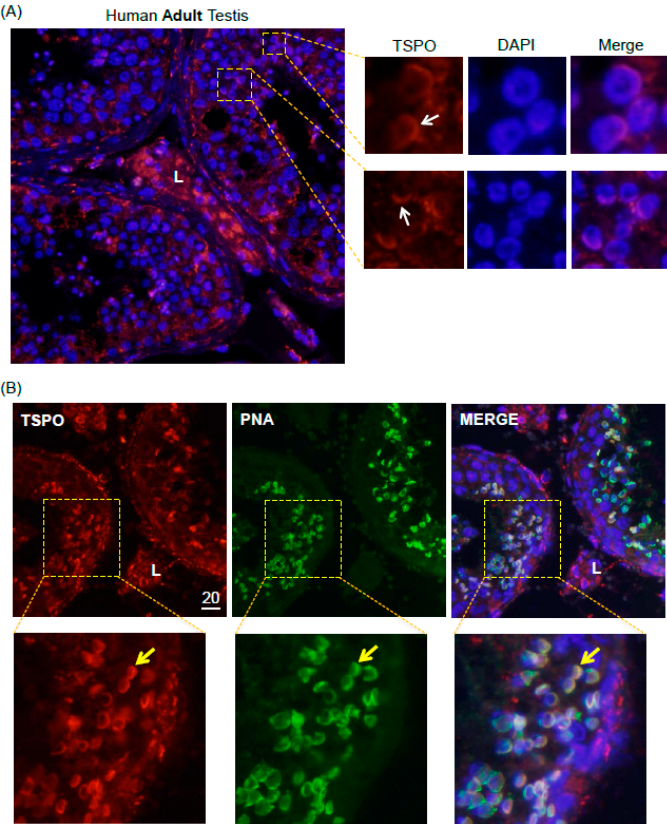
Figure 4. TSPO protein expression in normal human adult testis. Immunofluorescence (IF) analysis was performed on paraffin sections. ( A ) Patient 1. Red : TSPO protein expression; Blue : DAPI nuclear staining. Leydig cells are indicated by “L”. Areas showing expression in round spermatids (acrosomal formation) are shown in enlarged panels. Representative images are shown; ( B ) Patient 2. Red : TSPO protein expression; Green : PNA labeling; Blue : DAPI nuclear staining. Examples of co-localization between TSPO and PNA are indicated by yellow arrow in enlarged panels. Representative images are shown. Scale bar: 20 μ m.